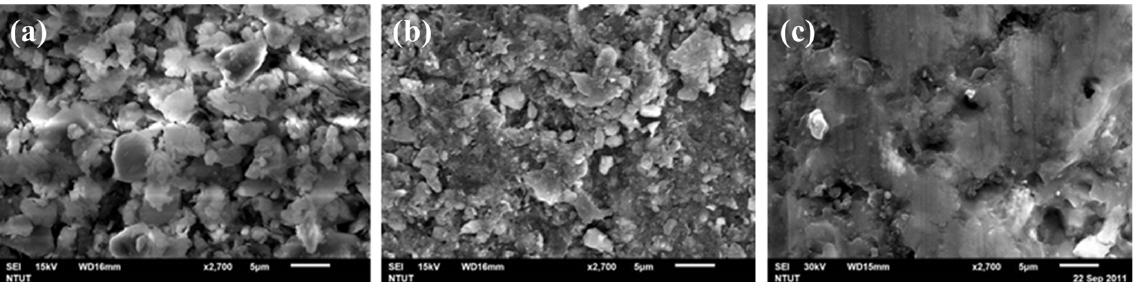
Figure 3. SEM images of building brick sintered at different temperature: ( a ) 600 ◦ C; ( b ) 800 ◦ C; ( c ) 1000 ◦ C.